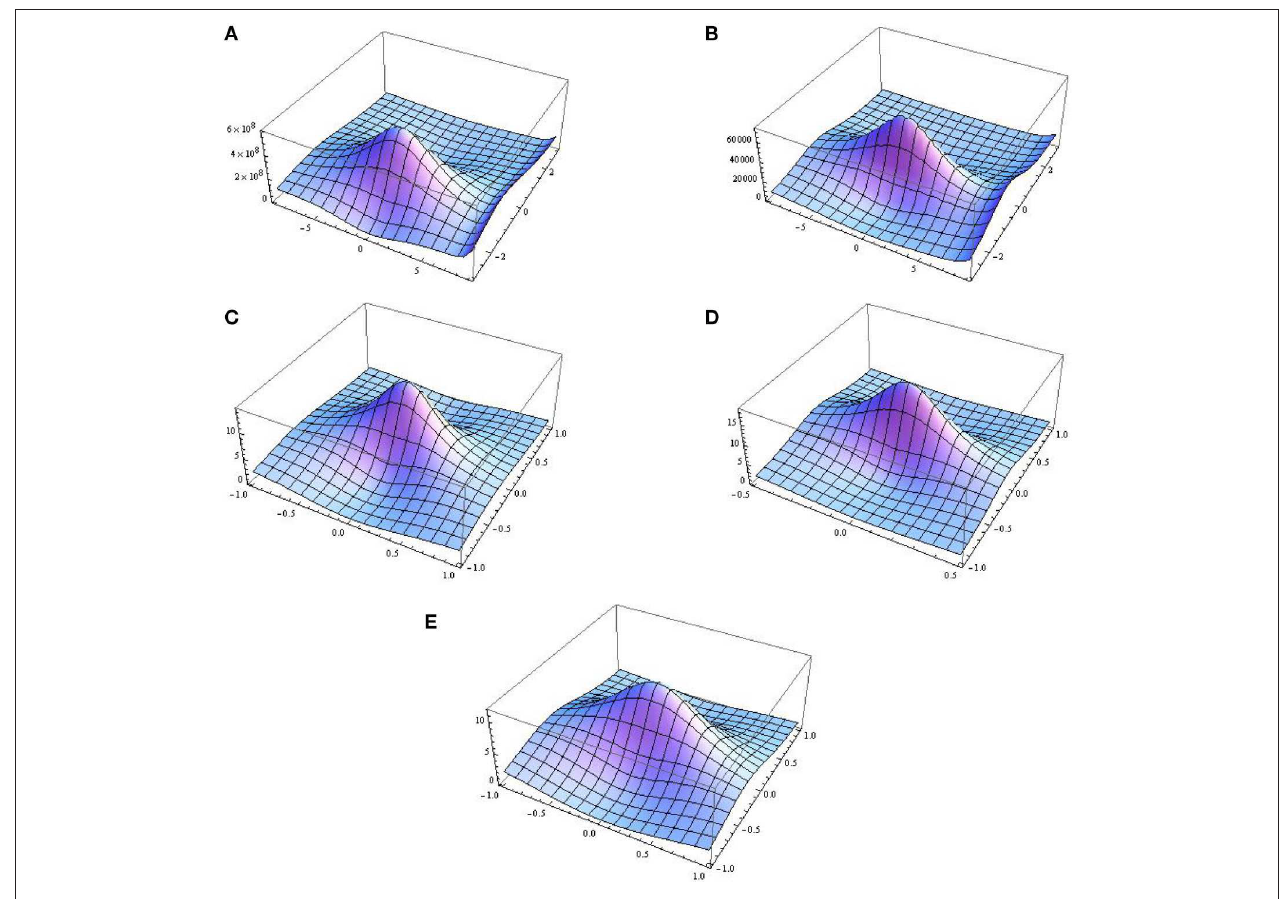
FIGURE 1 | 3D graphical representations of first-order rogue waves. (A) b δ ( t ) 0.7 0.9cos(0.1 t ), (D) δ 0 ( t ) = +